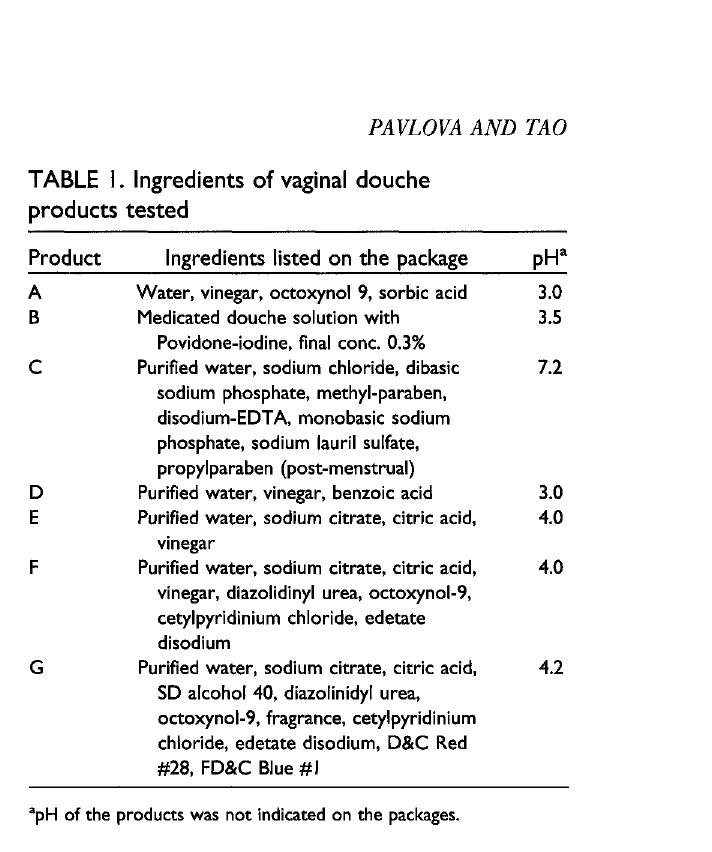
TABLE I. Ingredients of vaginal douche products